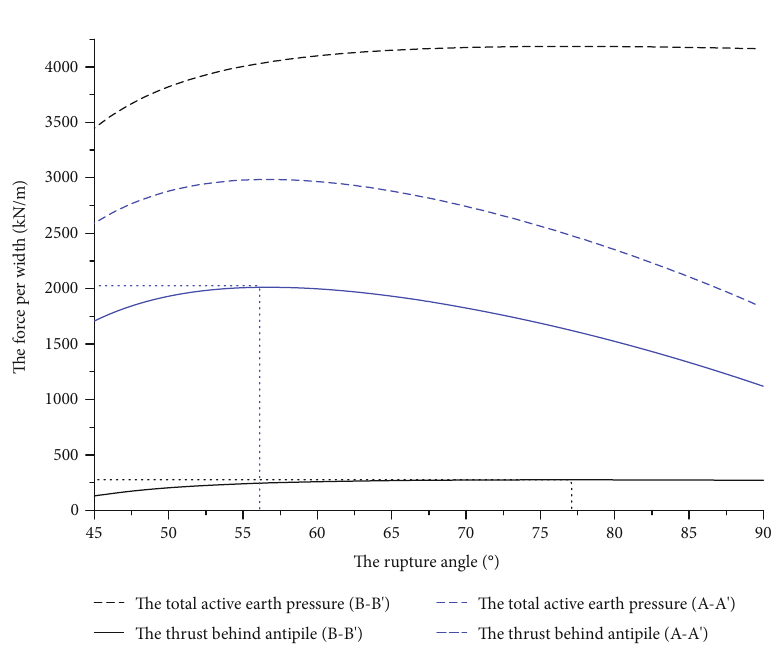
Figure 10: The active earth pressure and the thrust behind the antipiles with di ff erent rupture